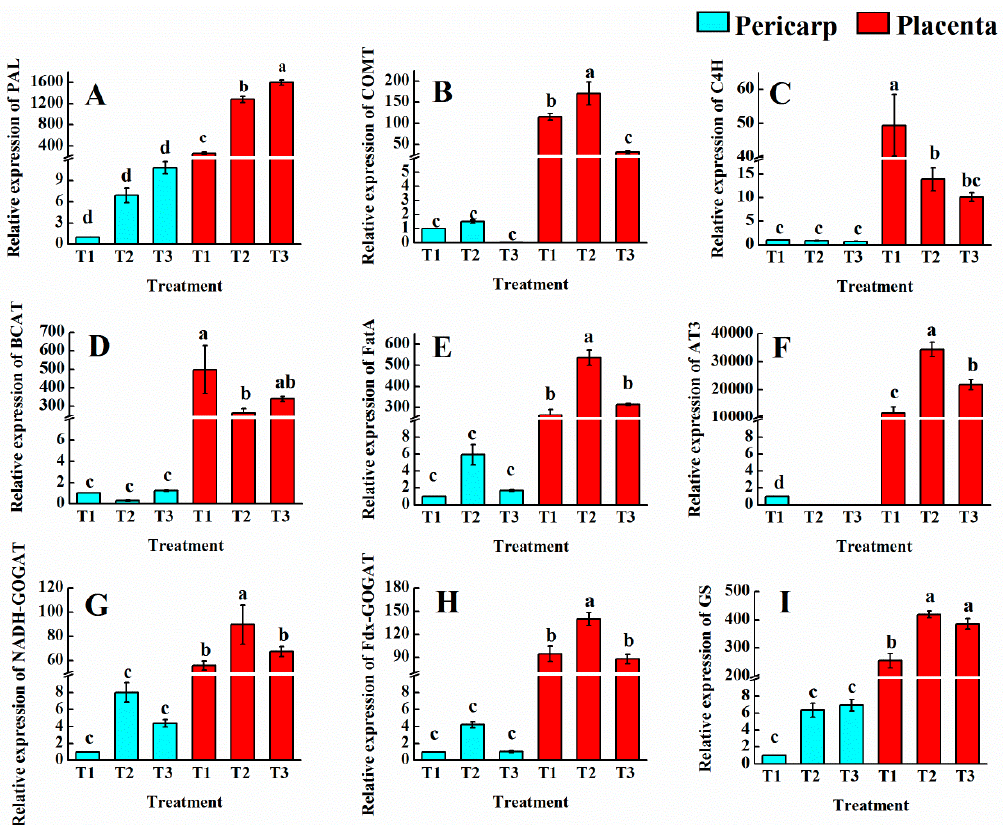
Figure 7. Relative expression level of genes in pericarp and placenta. ( A) PAL (phenylalanine